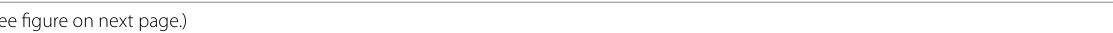
figure on next Fig. 7 Live/dead differentiation of T-NPs on bacteria and intracellular ROS generation analysis. a Fluorescence images of live and dead P. gingivalis and A. viscosus cultured in the TSB medium with 1/2 MIC T-NPs, MIC T-NPs or without T-NPs and stained with calcein-AM and PI. b a group of fluorescence images of dead bacteria. Fluorescence images were captured under the excitation of 488 and 552 nm, respectively. And red dots represented dead bacteria and green dots represent live bacteria. c Fluorescence images of P. gingivalis and A. viscosus cultured in the TSB medium with 1/2 MIC T-NPs, MIC T-NPs or without T-NPs and incubated with DCFH-DA. Fluorescence images were captured under the excitation of 488 nm. d The fluorescence intensity of ROS in P. gingivalis . e The fluorescence intensity of ROS in A. viscosus was